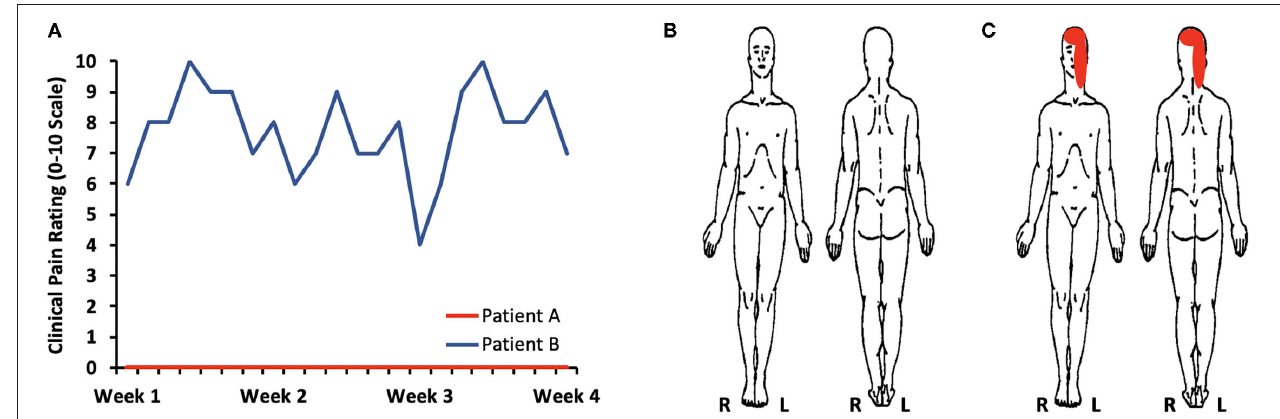
FIGURE 1 | Clinical pain levels. (A) Self-reported daily pain levels over 4 weeks confirms the presence of little to no pain for Patients A (average pain: 0.4/0–10 scale) and moderate to severe pain for Patient B (average pain: 7.8/0–10 scale). (B) A body map further defined an absence of pain in Patient A. (C) Patient B described pain primarily on the left side of her face and over the majority of the